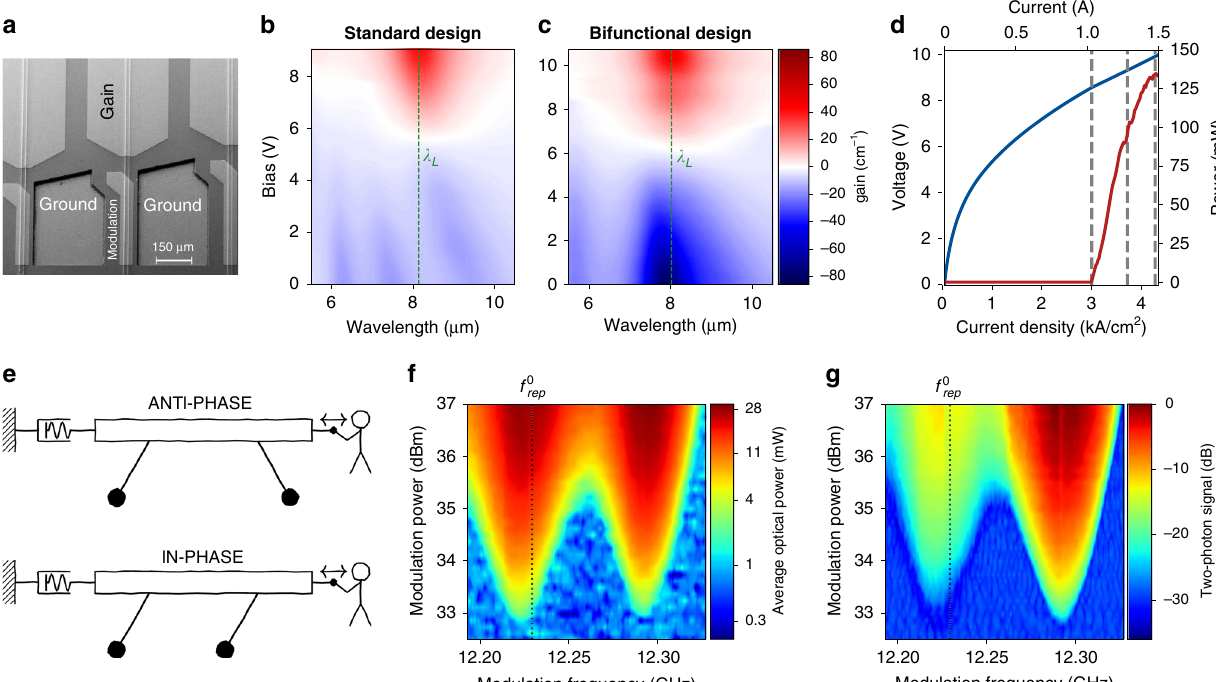
Fig. 1 Bi-functional quantum cascade lasers for mode-locking. a Scanning electron microscope image of three adjacent laser ridges. Each laser consists of a roughly 3 mm long gain section and a shorter (320 – 480 μ m) modulation section. b Simulated gain and loss spectrum in a standard active region design 46 depending on the applied bias. Upon decreasing the bias, the structure becomes almost transparent at the lasing wavelength λ L , limiting the maximally achievable modulation depth. c Simulated gain and loss spectrum in a bi-functional active region design 12 , allowing to tune the gain at 10 V continuously to absorption (shown as negative gain) at 0 V. d Measured light – current – voltage (L – I – V) characteristics of an epi-up mounted bi-functional QCL at 15 °C. e Illustration of a system of coupled oscillators. This system shows an in-phase and anti-phase synchronization state, which oscillate at different frequencies depending on the coupling. Without external stimulation, the anti-phase state is more favorable due to the damped coupling. However, both synchronization frequencies can be probed by exerting mechanical force on the platform coupling the oscillators. In the QCL, the oscillators are represented by the intermode beatings, which tend to synchronize in anti-phase due to gain damping 19,30 . Both synchronization frequencies are probed by applying modulation to the laser. f Average optical power depending on the modulation frequency and power. Two synchronization states at f 0 60 MHz above are observed. g Signal of a 2-QWIP sensitive to peak power as function of modulation frequency and power. The strongly increased signal + 60 MHz indicates in-phase of the lobe at f 0 rep